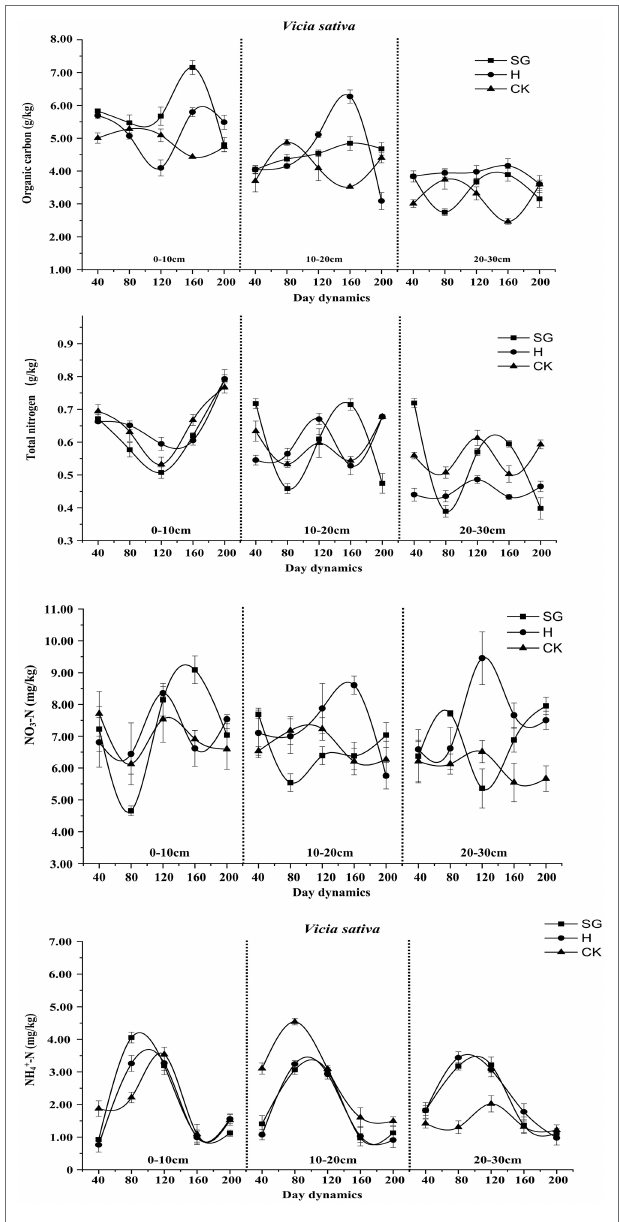
FIGURE 10 | Dynamic changes of soil nutrients of Vicia sativa + Avena sativa